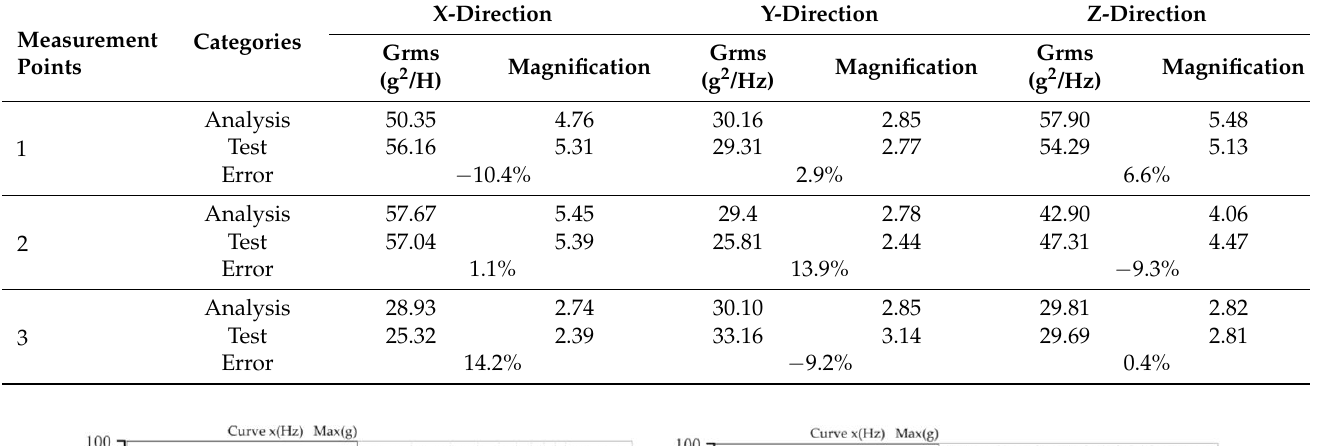
Table 9. PSD response after model correction.